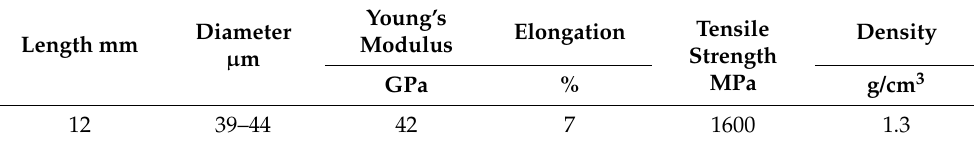
Table 3. Physical and geometrical properties of polyvinyl alcohol (PVA) fibers.